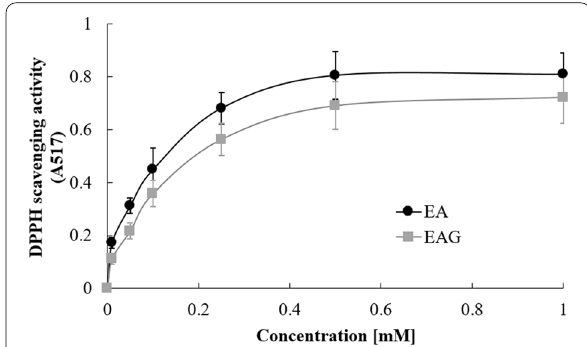
Fig. 4 DPPH radical‑scavenging activities of EA and EAG at concentrations of 0, 0.01.0.05, 0.1, 0.25, 0.5, and 1.0 mM. The reaction was monitored at 517 nm. Data are reported as mean separate